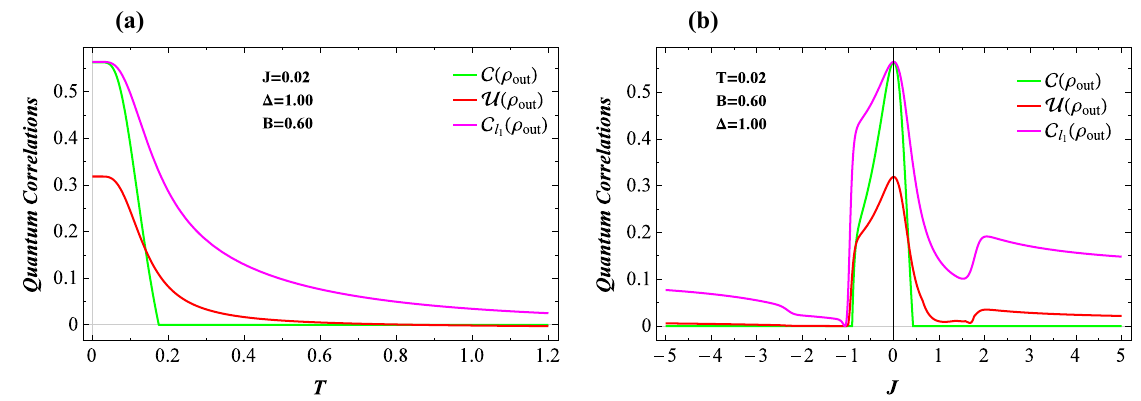
Figure 6. ( a ) Three quantum criteria for the output state versus temperature T and parameter sets J = 0.02 , (cid:31) = 1 , and B = 0.6 . ( b ) The same quantifiers as functions of the coupling constant J at low temperature T = 0.02 , assuming (cid:31) = 1 and B = 0.6